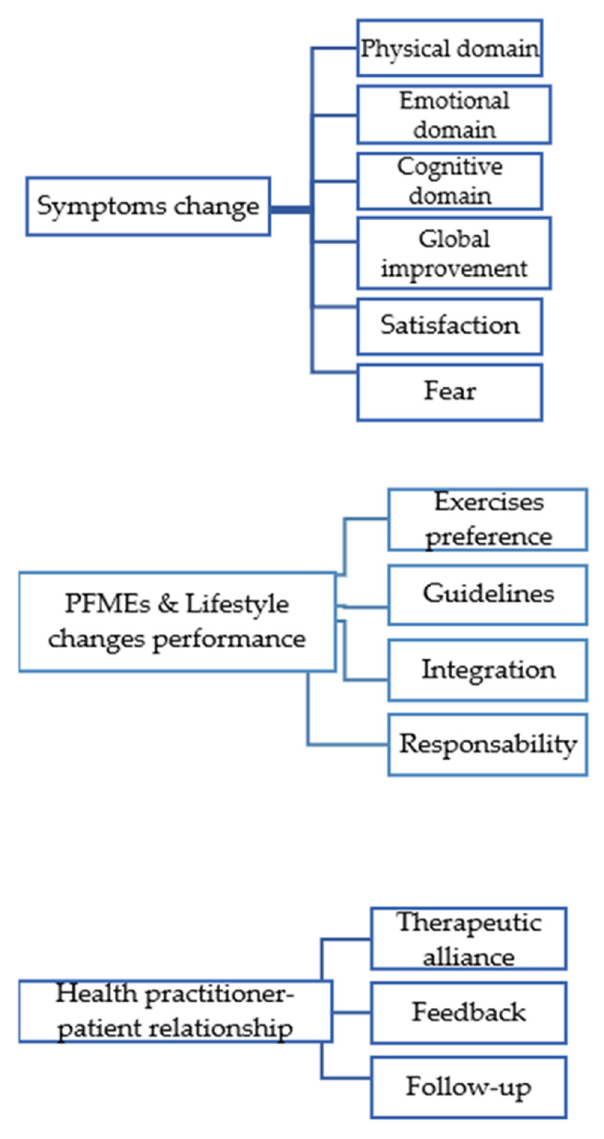
Figure 1. Summary of themes and codes. PFMEs: pelvic floor muscle exercises.